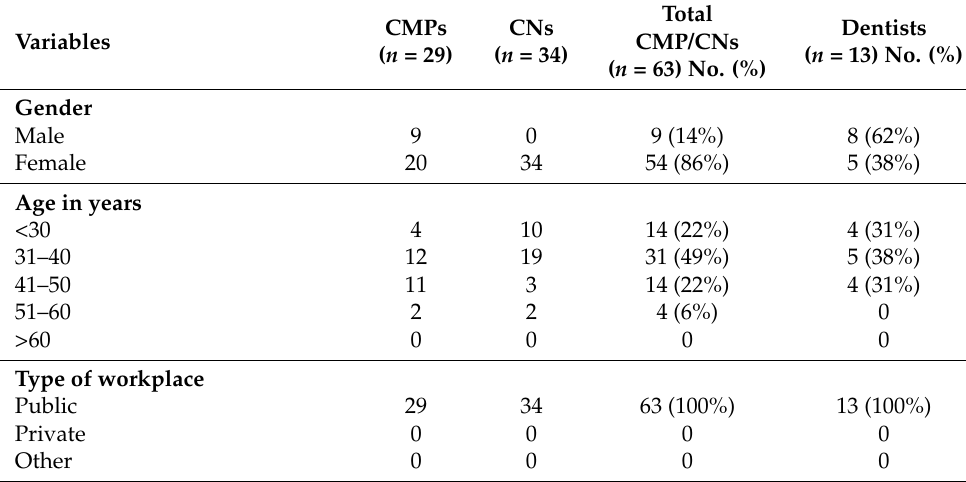
Table 1. Demographics of participants in Shanghai (community medical practitioners (CMPs), community health nurses (CNs) and